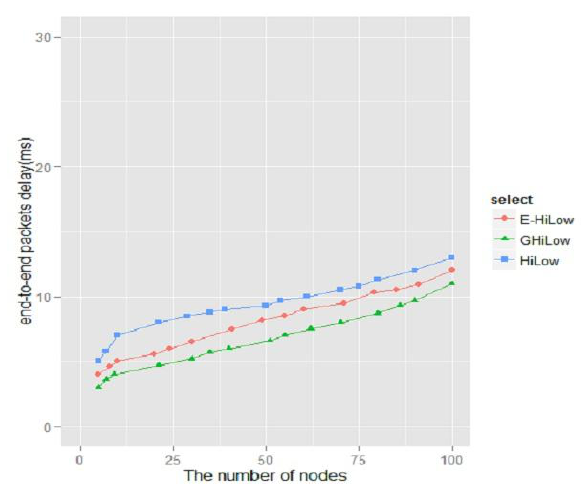
Figure 4. End-to-end packets